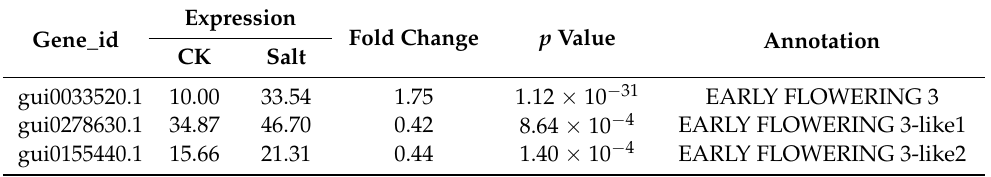
Table 1. Analysis of differently expressed OfELF3-like genes after salt treatment.